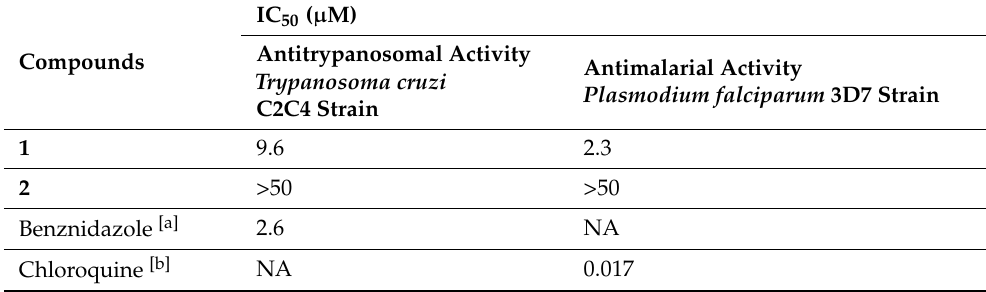
Table 3. In vitro antitrypanosomal and antimalarial activities of 1 and 2 .